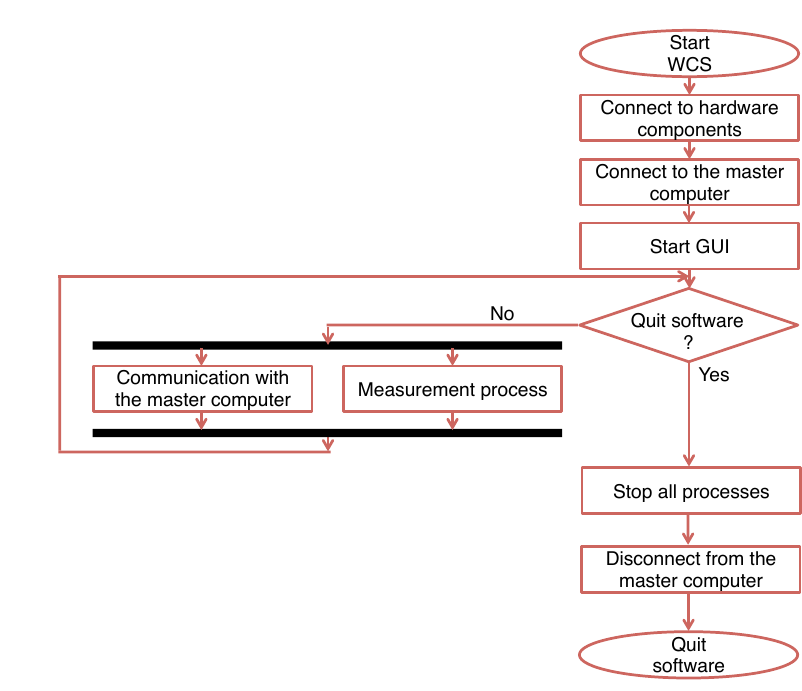
Figure 4. WCS flow diagram.